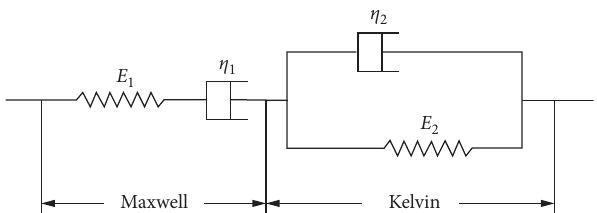
Figure 18: Schematic diagram of four-element Burger’s